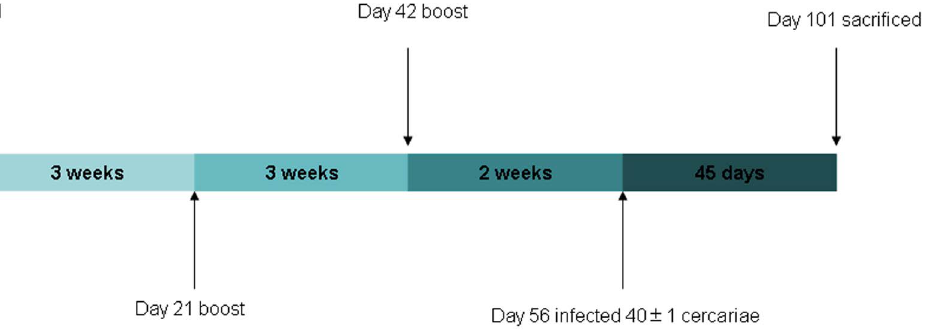
Figure 2. Mouse immunization protocol. Three groups of mice (10 mice in each group) were subcutaneously injected with 100 m g secreted pIRES-sjFABP-sj26GST, membrane-anchored pIRES-sjFABP-sj26GST, and pIRES plasmids on day 1 and boosted on day 21 and 42. Two weeks after the last boost all mice were challenged with 40 6 1 cercariae by abdominal skin penetration. Forty-five days post challenge, the mice were sacrificed.